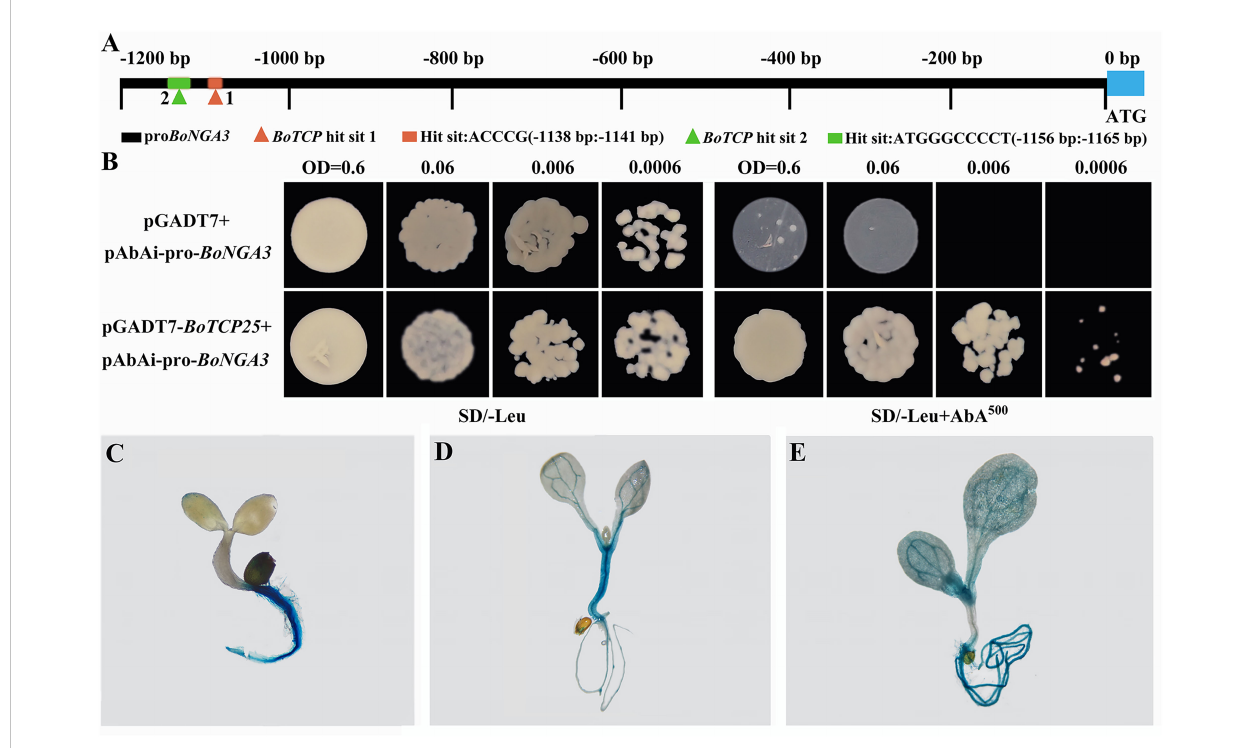
FIGURE 6 Yeast one hybrid and GUS staining of BoNGA3 promoter -GUS transgenic Arabidopsis plants. (A) Schematic diagram of potential interaction sites between BoTCP25 and BoNGA3 ’ s promoter. (B) Veri fi cation of the binding of BoTCP25 to the promoter of BoNGA3 by Yeast one hybrid method. GUS staining of BoNGA3 promoter -GUS transgenic Arabidopsis plants at 3 DAS (C) , 5 DAS (D) , and 10 DAS (E) . DAS, Days After